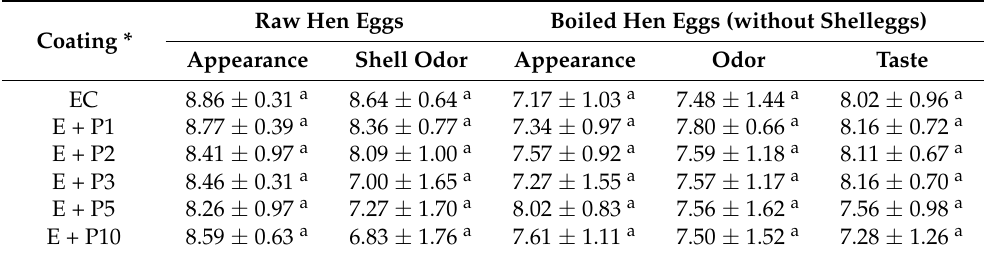
Table 4. Assessment of sensory factors of hen eggs coated with propolis extract in concentrations of 1, 2, 3, 5 and 10%. Raw Hen Eggs Boiled Hen Eggs (without Shelleggs) Coating * Appearance Shell